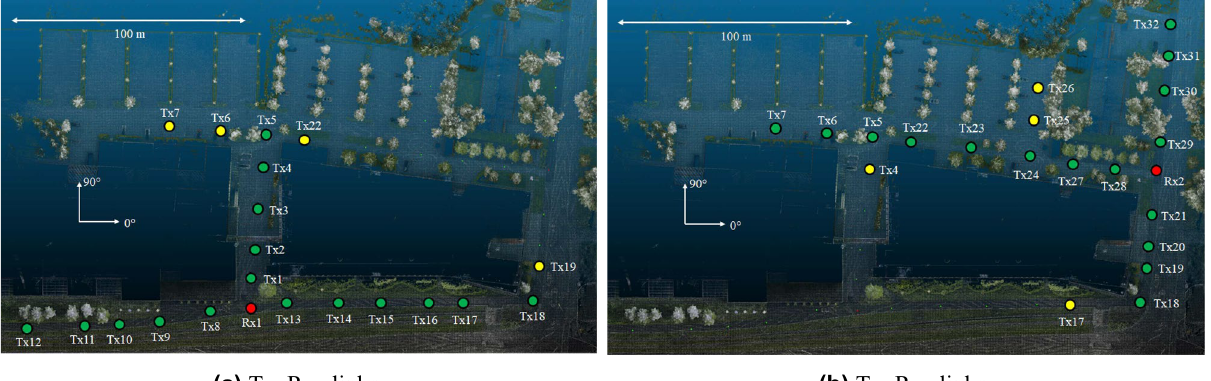
Figure 1. Top-view of the outdoor campus